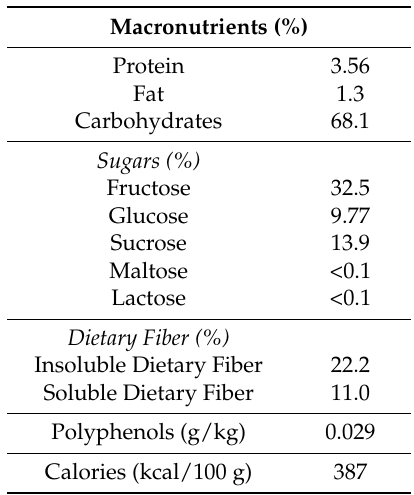
Table 2. Composition of freeze-dried apple pomace substituted (10% g/kg) into diets fed to growing female